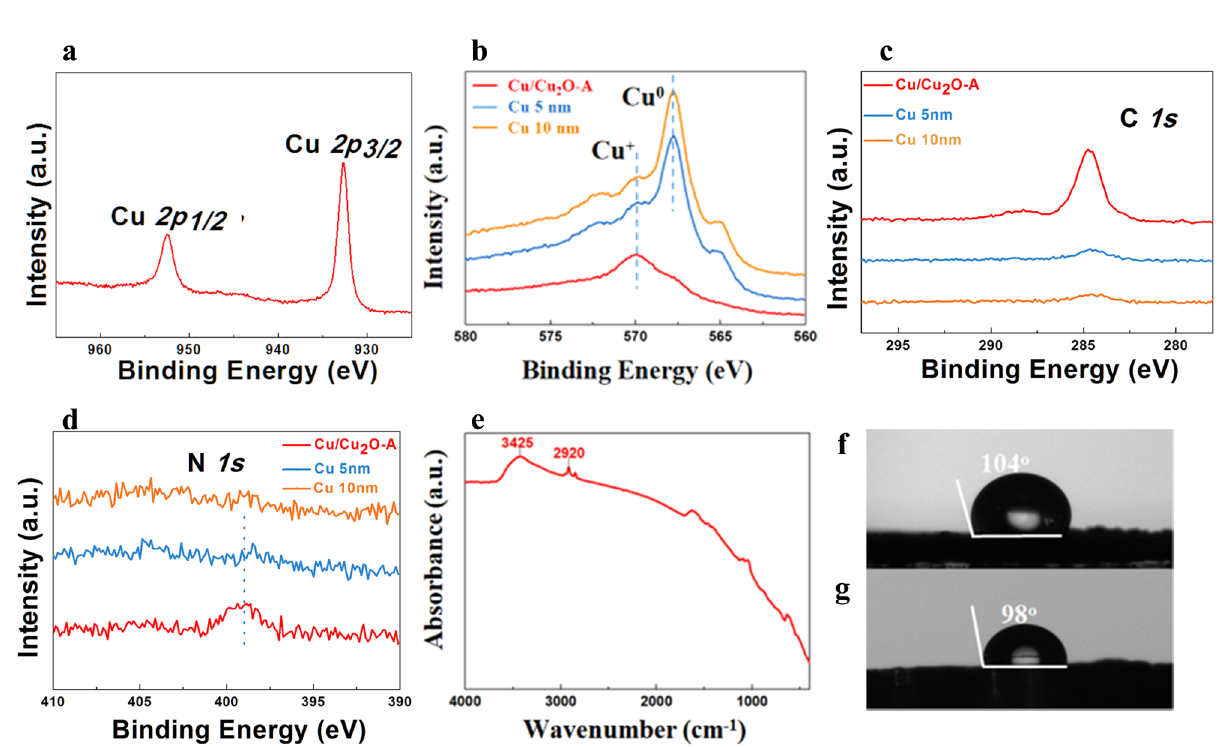
Cu 10nm refers to Cu/Cu 2 O-A catalyst etched with 10nm depth). e FT-IR of Cu/